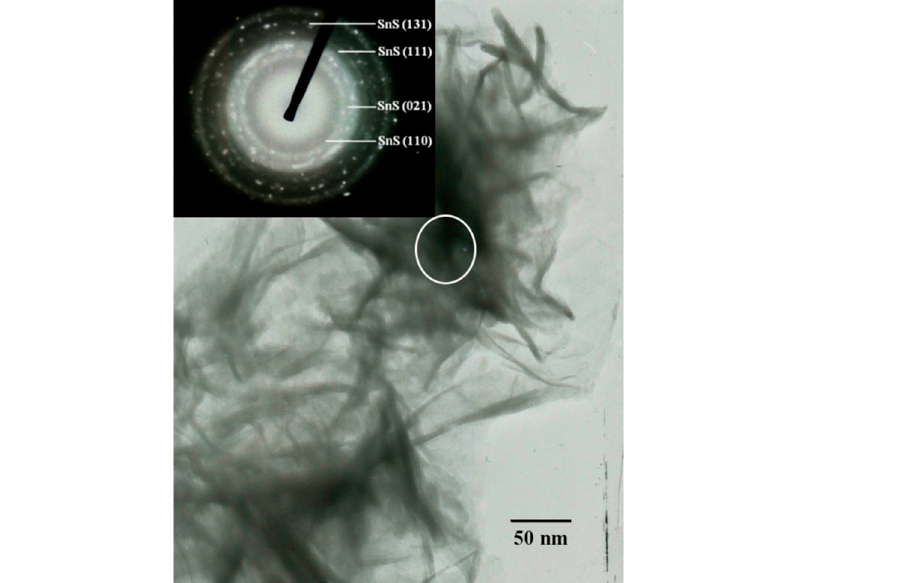
Figure 2. Transmission electron microscope (TEM) image and selected-area electron diffraction (SAED) pattern of the SnS structure of the as prepared 10SnS/AG sample. In all prepared nano- composites, the SnS particles had this microstructure.